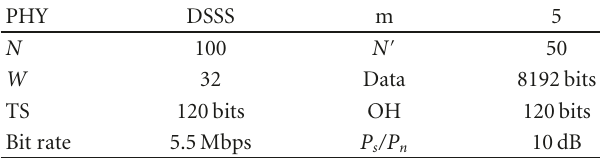
Figure 14: Saturation throughput (Mbits/s) for di ff erent α , TC = 2 ms . Table 3: Common